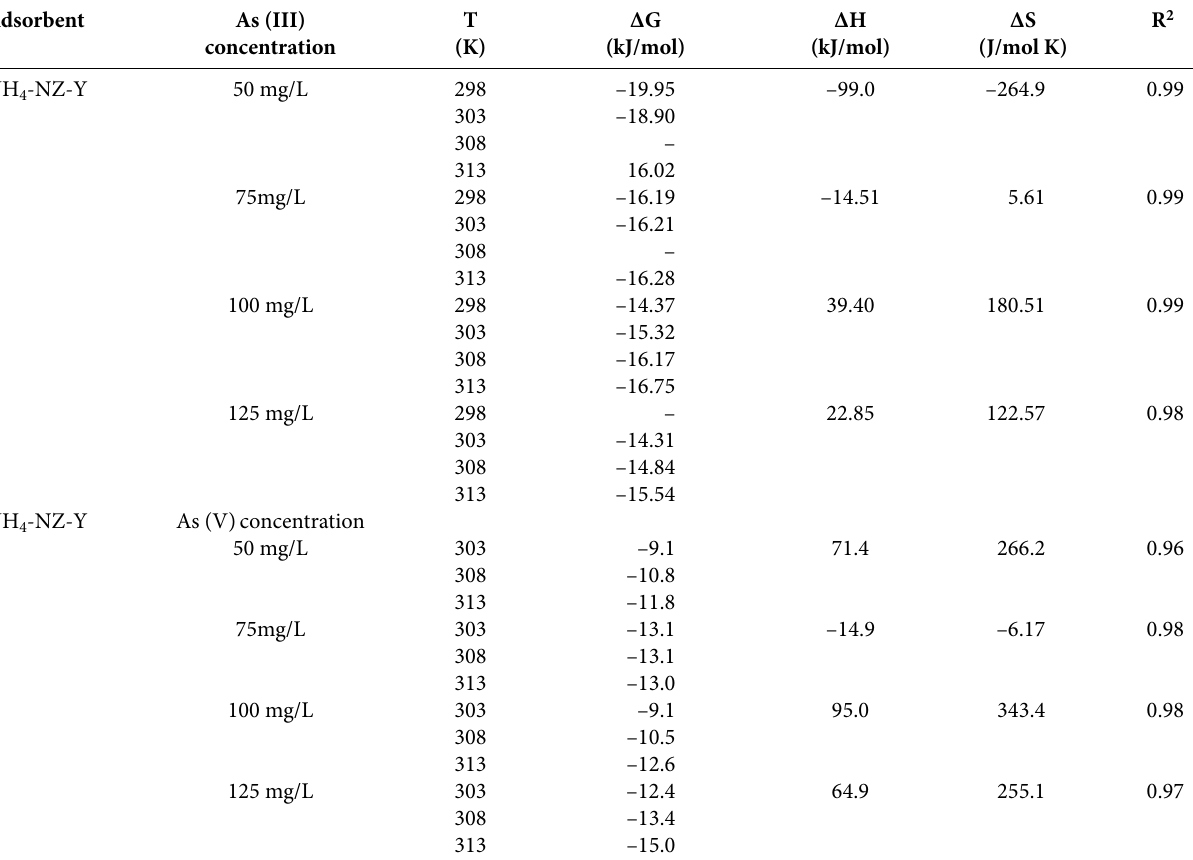
Table 6. Thermodynamic data for As (III&V) on NH 4